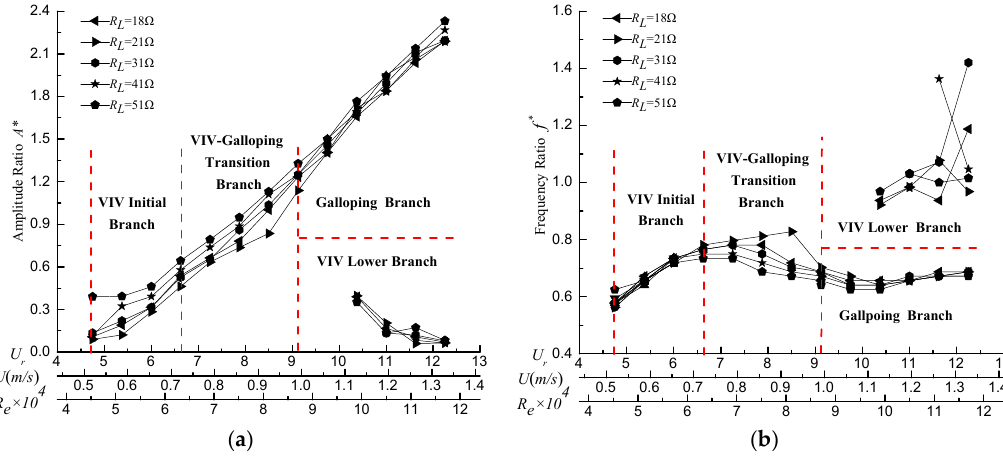
Figure 11. Soft galloping (SG) oscillation characteristics 18 Ω ≤ R L ≤ 51 Ω (0.115 ≤ ζ ≤ 0.165): ( a ) response of the amplitude ratio; ( b ) response of the frequency ratio.